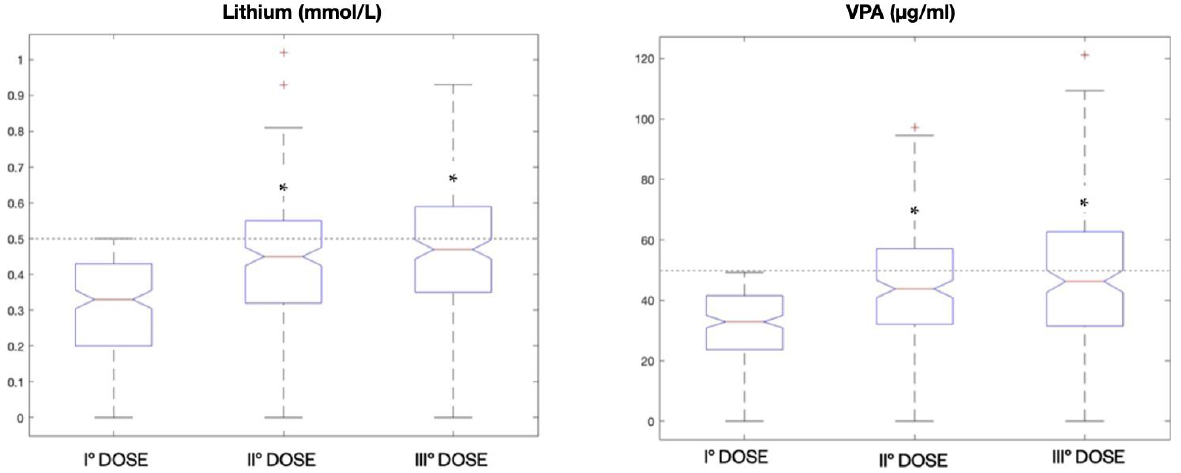
Figure 7. Boxplot representations of median lithium Cp (mmol/L) and VPA Cp ( µ g/mL) in patients (198) from the psychiatric unit receiving three consecutive dosing within the year starting from a subtherapeutic concentration. * p < 0.001 compared to the first dose by Kruskal – Wallis test.